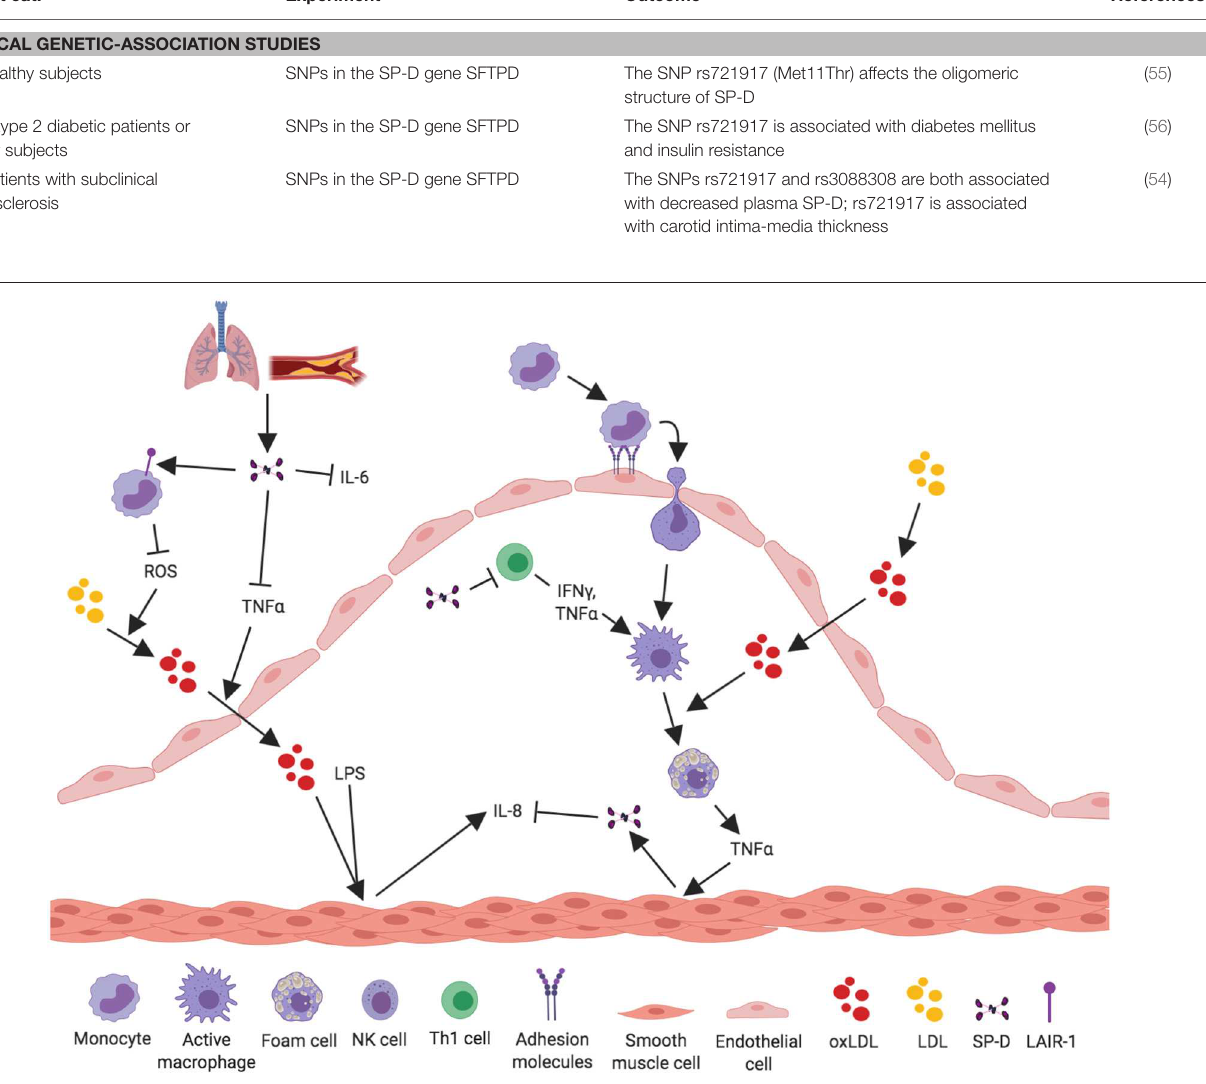
FIGURE 2 | Proposed anti-inflammatory mechanisms for SP-D in the development of atherosclerosis. SP-D plays a dual role in the development of atherosclerosis. This figure aims to depict what we know about the anti-inflammatory properties of SP-D in the development of atherosclerosis. Circulatory SP-D originates from lung-spillover or directly from the atherosclerotic artery. SP-D binds its receptor LAIR-1 on PBMCs, leading to inhibition of ROS and thereby inhibition of the oxidation process of serum LDL. Circulatory SP-D also inhibits circulatory IL-6 and TNF- α and thus the transport of oxidized LDL from the artery lumen to the subendothelial space. SP-D has been shown to inhibit the proliferation of Th1 cells and their secretion of IFN- γ and TNF- α ; this ultimately leads to inhibition of activated macrophages and foam cell formation. TNF- α secretion from NK cells and foam cells stimulates vascular smooth muscle cells (VSMC) to produce and secrete SP-D into the subendothelial space, where it again exerts its negative-feedback loop on NK cells. SP-D is able to inhibit IL-8 from LPS-stimulated VSMC, thus decreasing vascular inflammation.